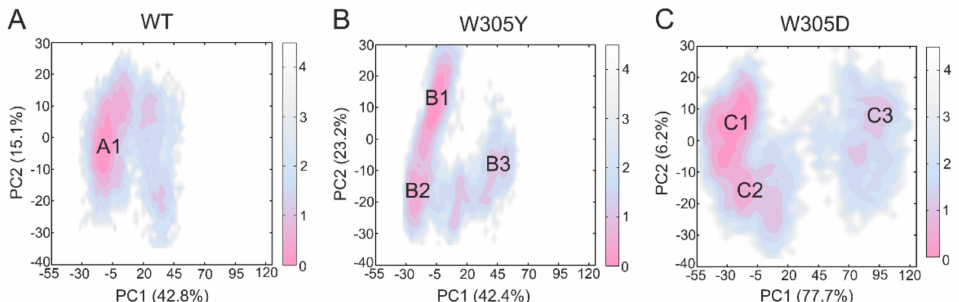
Figure 4. The free energy landscape of the first and second principal components (PC1 vs. PC2) from MD simulations of the WT ( A ), W305Y ( B ), and W305D ( C ) systems. The unit of free-energy values is kcal/mol. The representative DAPK1–CaM structural complex for the WT (A1), W305Y (B1, B2, and B3), and W305D (C1, C2, and C3) are